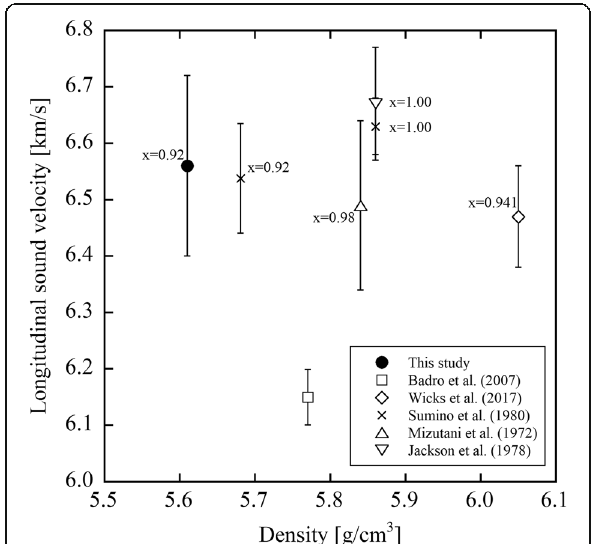
Fig. 4 Comparison of the V P – ρ relationships of FeO under ambient and low pressures. The values next to symbols indicate the percentage of Fe in Fe x O